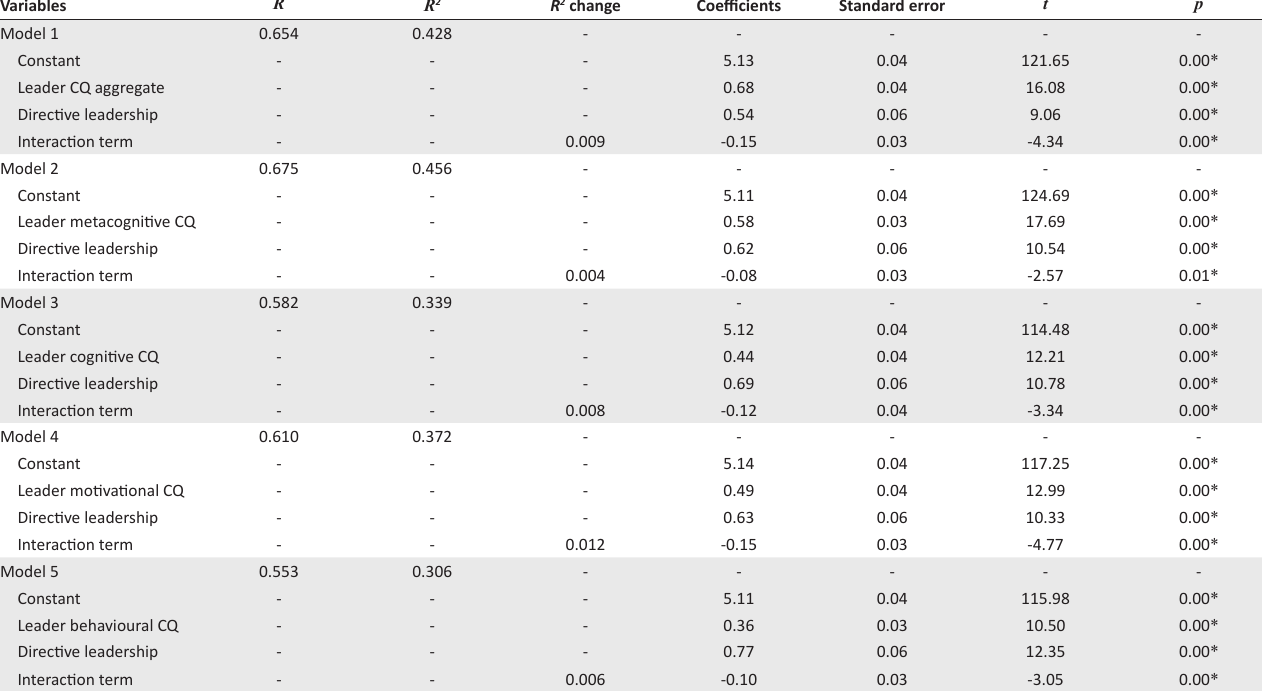
TABLE 8: Moderated multiple regression – Directive leadership and leadership effectiveness.